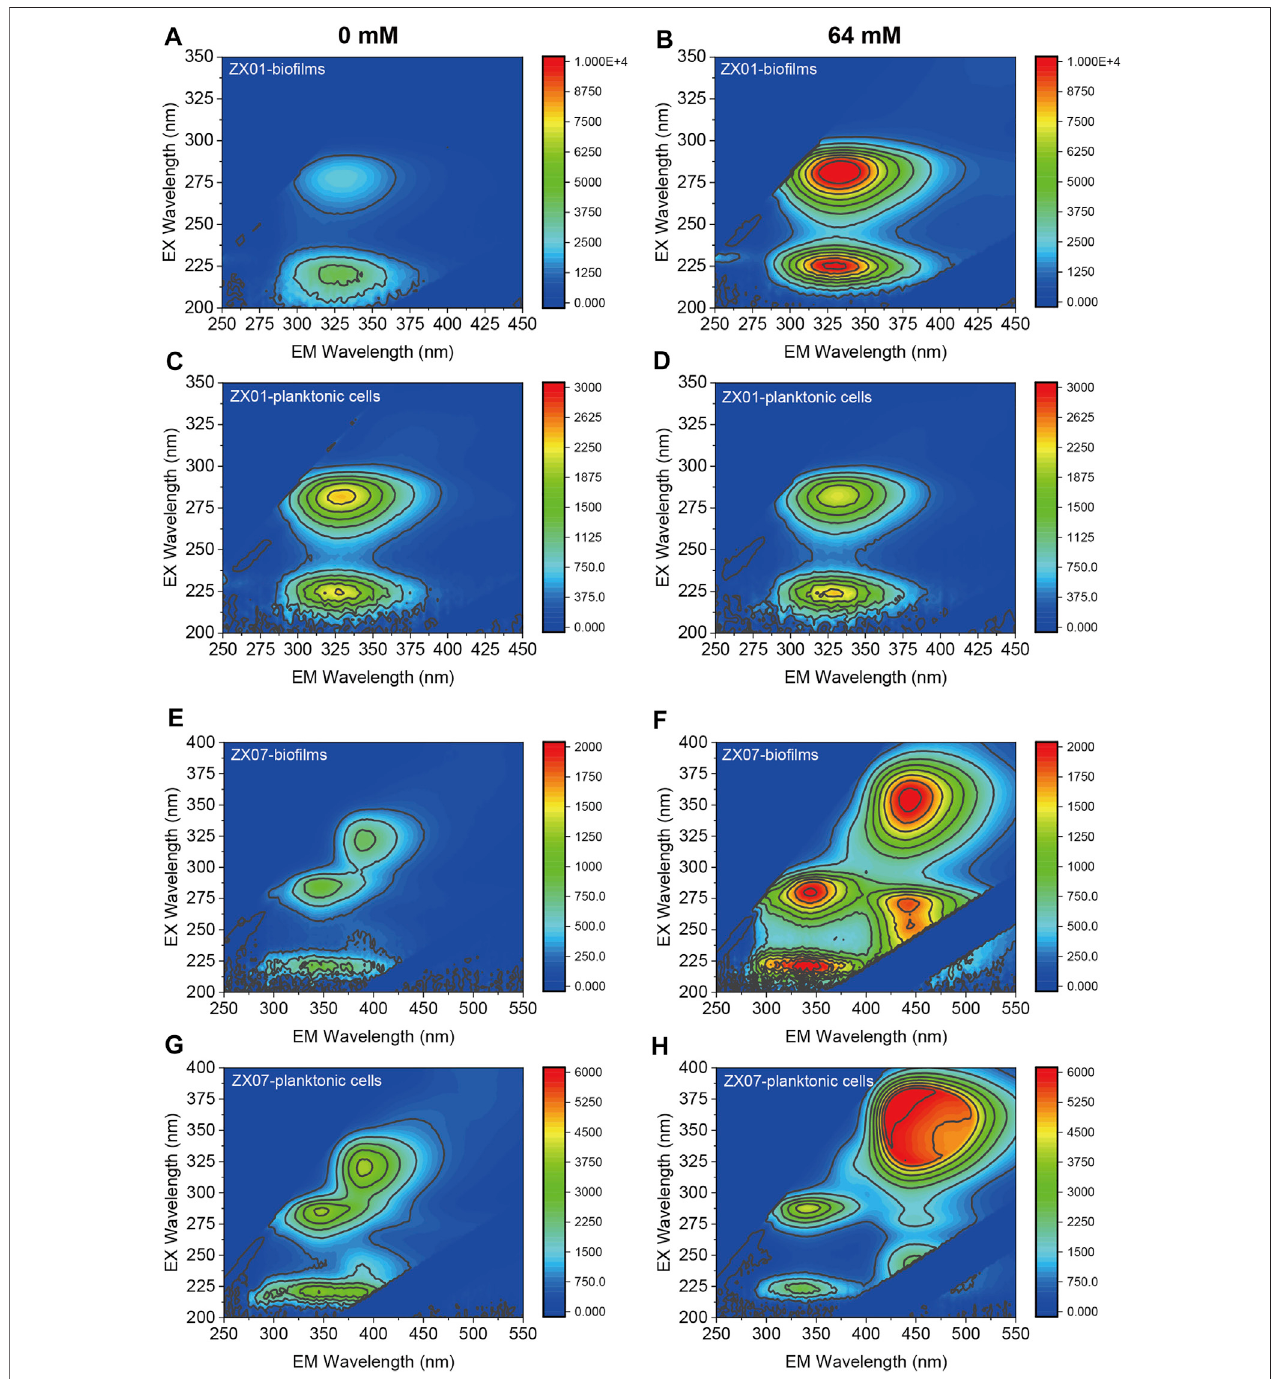
FIGURE 5 | EEM fl uorescence spectra of the EPS produced by both bio fi lms and planktonic cells. (A,B) Bio fi lms of Pseudomonas sp. ZX01 in the presence of 0 and 64 mM ofCaCl 2 (C,D) Planktonic cells of Pseudomonas sp. ZX01in thepresence of0and 64 mM ofCaCl 2 . (E,F) Bio fi lmsof Arthrobacter sp. ZX07in thepresence of 0 and 64 mM of CaCl 2 (G,H) Planktonic cells of Arthrobacter sp. ZX07 in the presence of 0 and 64 mM of CaCl 2 .